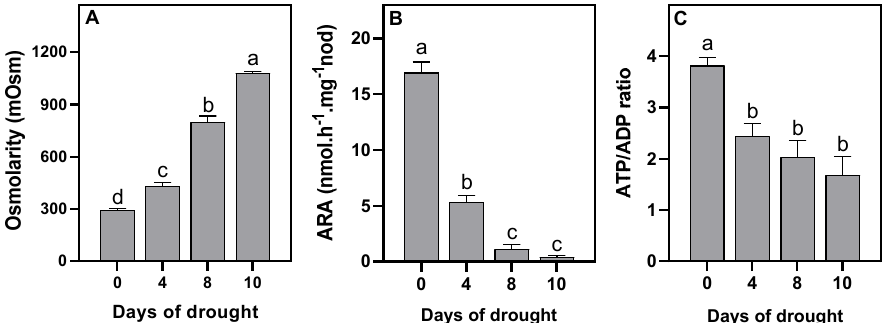
Figure 2. Effects of water deprivation on Vicia faba nodule osmolarity ( A ), ARA ( B ), and ATP/ADP ratio ( C ). Data are means ± SD of three biological replicates. Letters above the bars represent significant differences according to one-way ANOVA at p < 0.05 (Tukey’s multi-comparison test). ARA, acetylene-reducing activity.